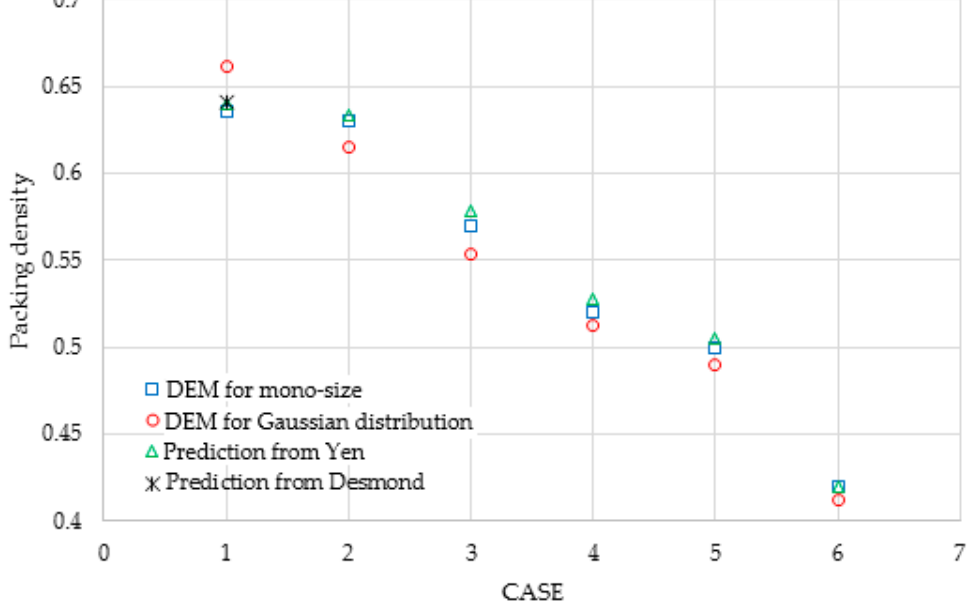
Figure 6. Comparison of packing density prediction by discrete element method (DEM) proposed in this paper with predictions from Yen and Desmond. (CASE 1: 300 μ m powders [35], CASE 2: 100 μ m powders without friction and Van der Waals forces, CASE 3: 100 μ m powders with frictional coefficient 0.3 and without Van der Waals forces, CASE 4: 100 μ m powders with frictional coefficient 0.3 and with Van der Waals forces, CASE 5: 100 μ m powders with frictional coefficient 0.7 and with Van der Waals forces, and CASE 6: 50 μ m powders with frictional coefficient 0.3 and with Van der Waals forces.)